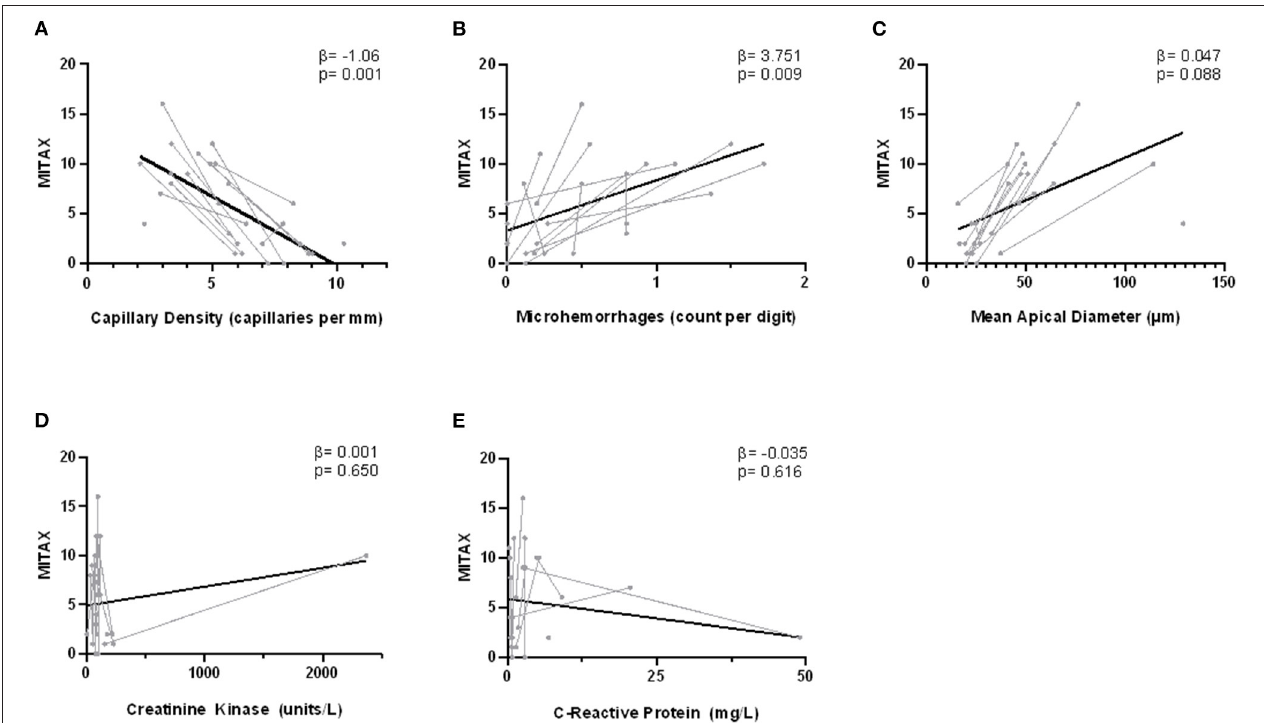
FIGURE 2 | Correlation between nailfold capillary measurements and MITAX. Disease activity is indicated on the y-axis as measured by the Myositis intention to treat index (MITAX). The NVC measurements capillary density (A) , microhemorrhages (B) , and apical diameter (C) as well as biochemical indices creatinine kinase (CK) (D) and C-reactive protein (CRP) (E) are indicated on the x-axes. Single assessments are indicated in gray, with lines connecting the longitudinal assessments for one individual patient. The overall fitted line is indicated in black. Fixed effect estimates ( β ) and significance ( p ) are the result of individual mixed-linear models with dependent variable MITAX and time as a random effect.